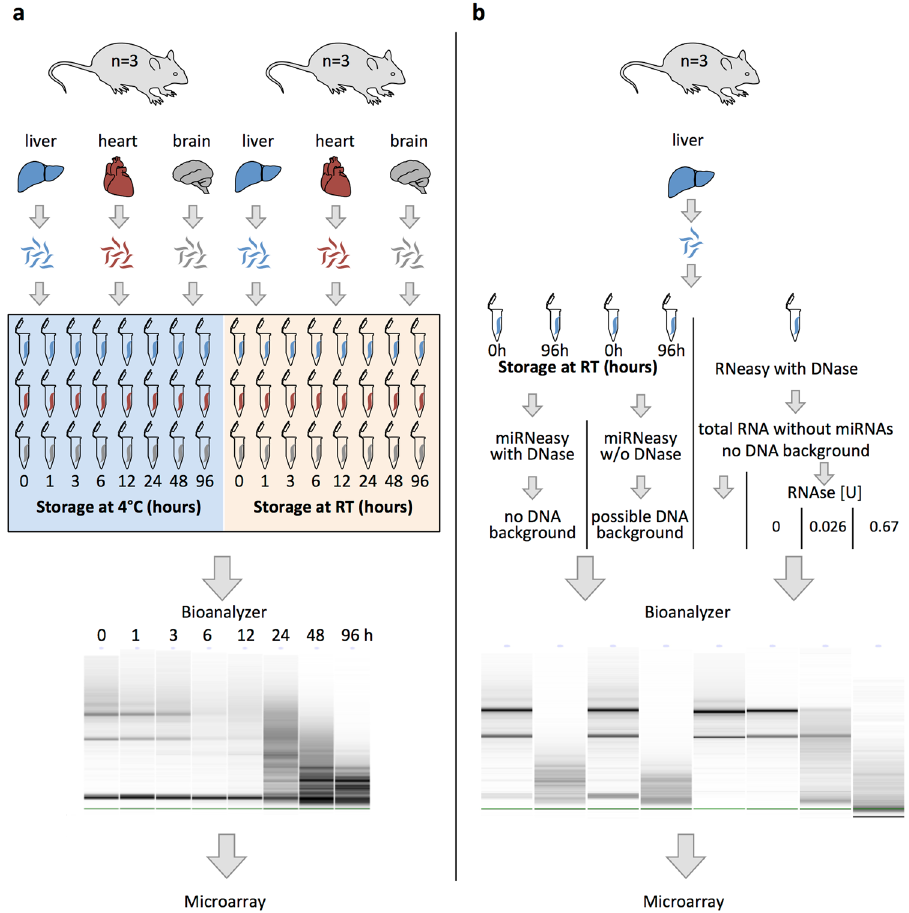
Figure 1. Experimental design. ( a ) Liver, heart and brain of male mice were harvested immediately after death, divided into 8 parts of about equal size, and stored at either 4 °C or at room temperature (RT) for the indicated time periods before RNA isolation. Experiments were performed in biological triplicates. RNA integrity was measured with Bioanalyzer. Gel-like image of brain tissue is given as example. MiRNA expression profiles of one replicate were measured using microarrays. ( b ) Liver tissue of 3 male mice was harvested immediately after death and divided into 5 parts of about equal size. Three parts were immediately transferred into RNAlater (0 h), two parts were stored for 96 h at room temperature (96 h). Two samples (0 h and 96 h) were isolated using standard procedure with miRNeasy Kit without DNase digestion. Two samples (0 h and 96 h) were isolated with optional DNase digestion to exclude DNA background. From the remaining undegraded sample (0 h), total RNA without small RNAs was isolated using RNeasy Kit with optional DNase digestion. Isolated RNA was further treated with 0 U, 0.026 U and 0.67 U RNase for 30 min to generate artificial RNA degradation. RNA integrity was measured with Bioanalyzer. MiRNA expression profiles of all replicates were measured